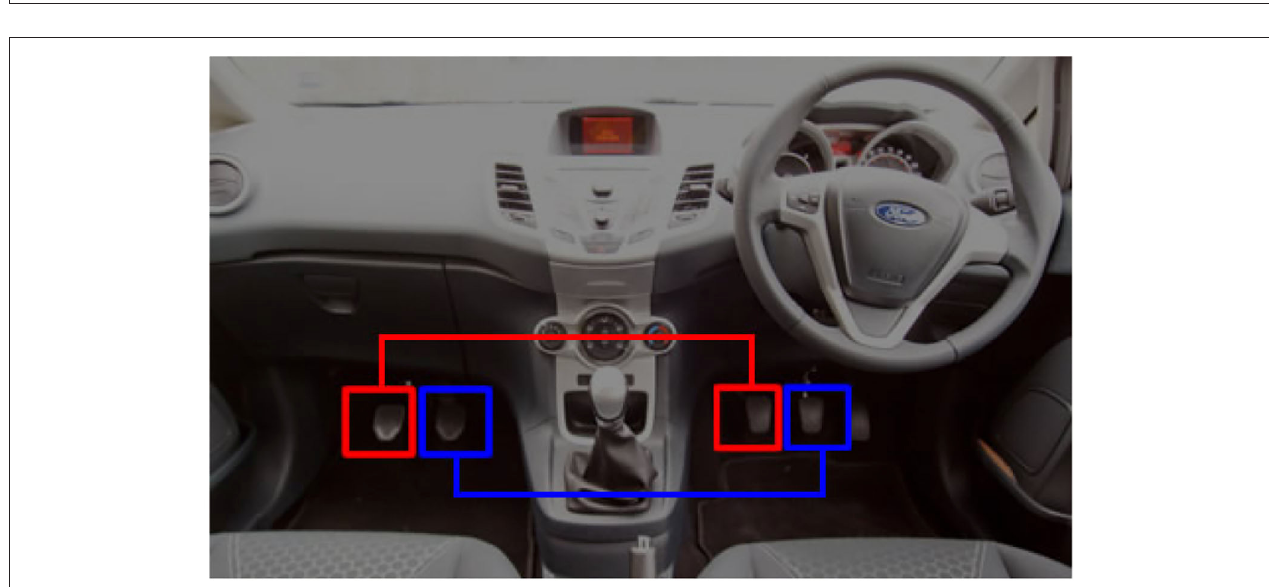
FIGURE 5 | Table of comparison of similar